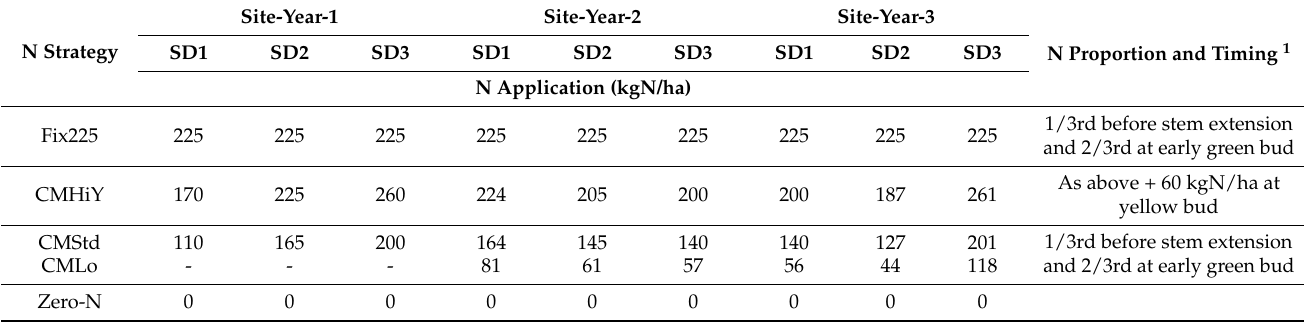
Table 2. Nitrogen application strategies: rates, and timing by